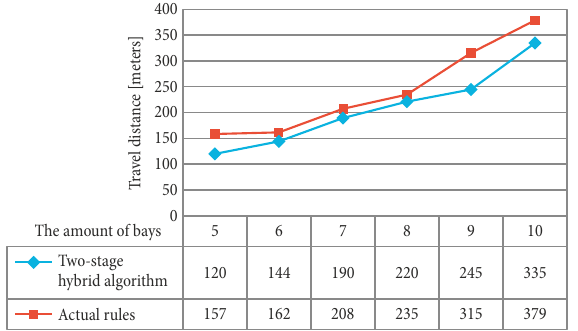
Fig. 6. Comparison of travel distance between two-stage hybrid algorithm and actual rules for small-sized cases